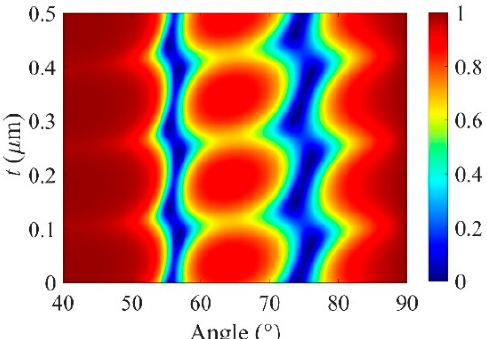
Figure 6. Reflectivity map on the plane of the incident angle and t with n p = 1.7. The other parameters are the same as used in Figure 3.